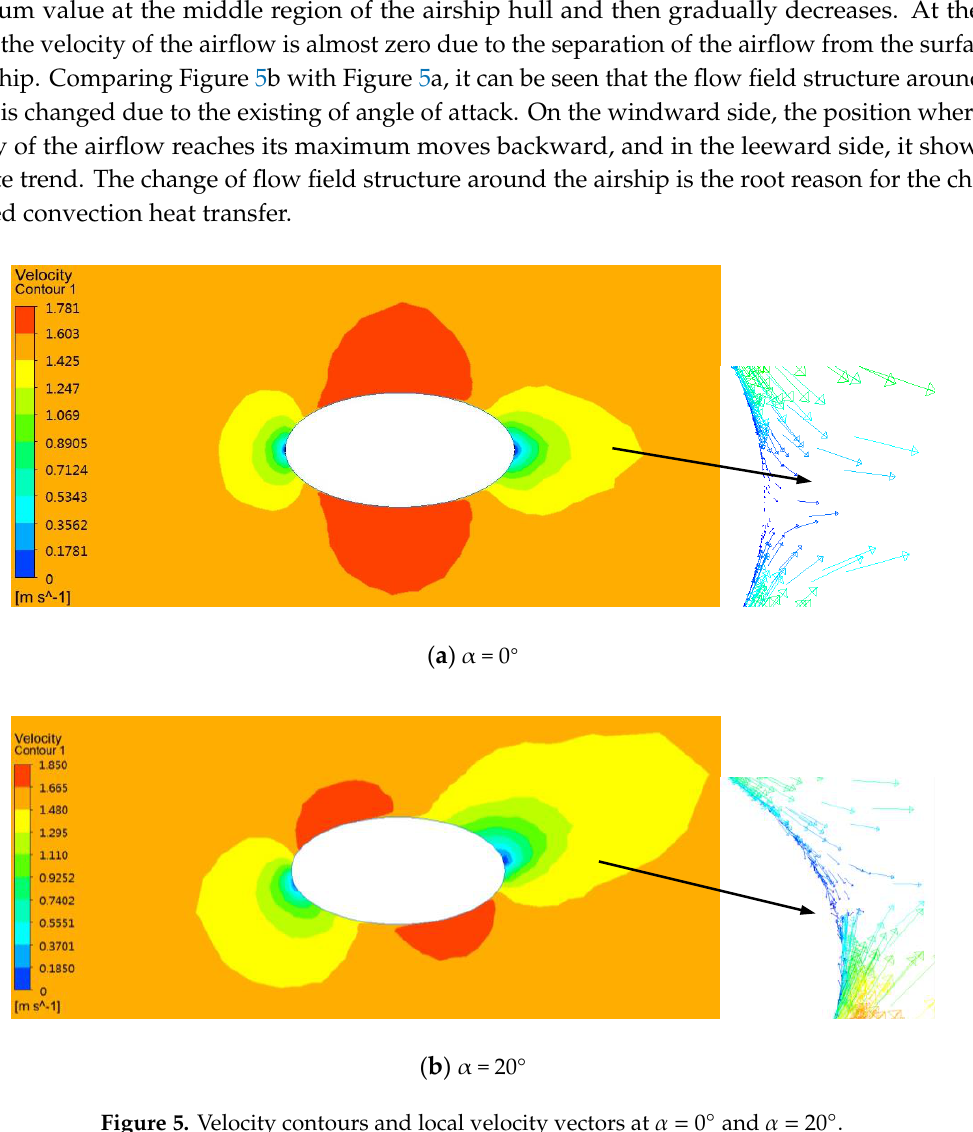
Figure 5. Velocity contours and local velocity vectors at α = 0° and α = 20°.